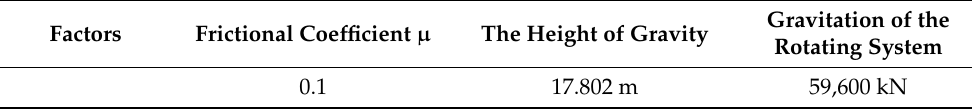
Gravitation of the Rotating System